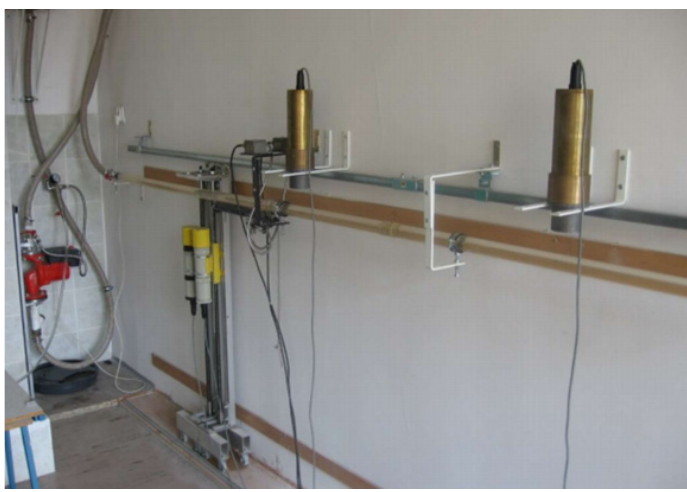
Figure 2. General view of the hydraulic installation.